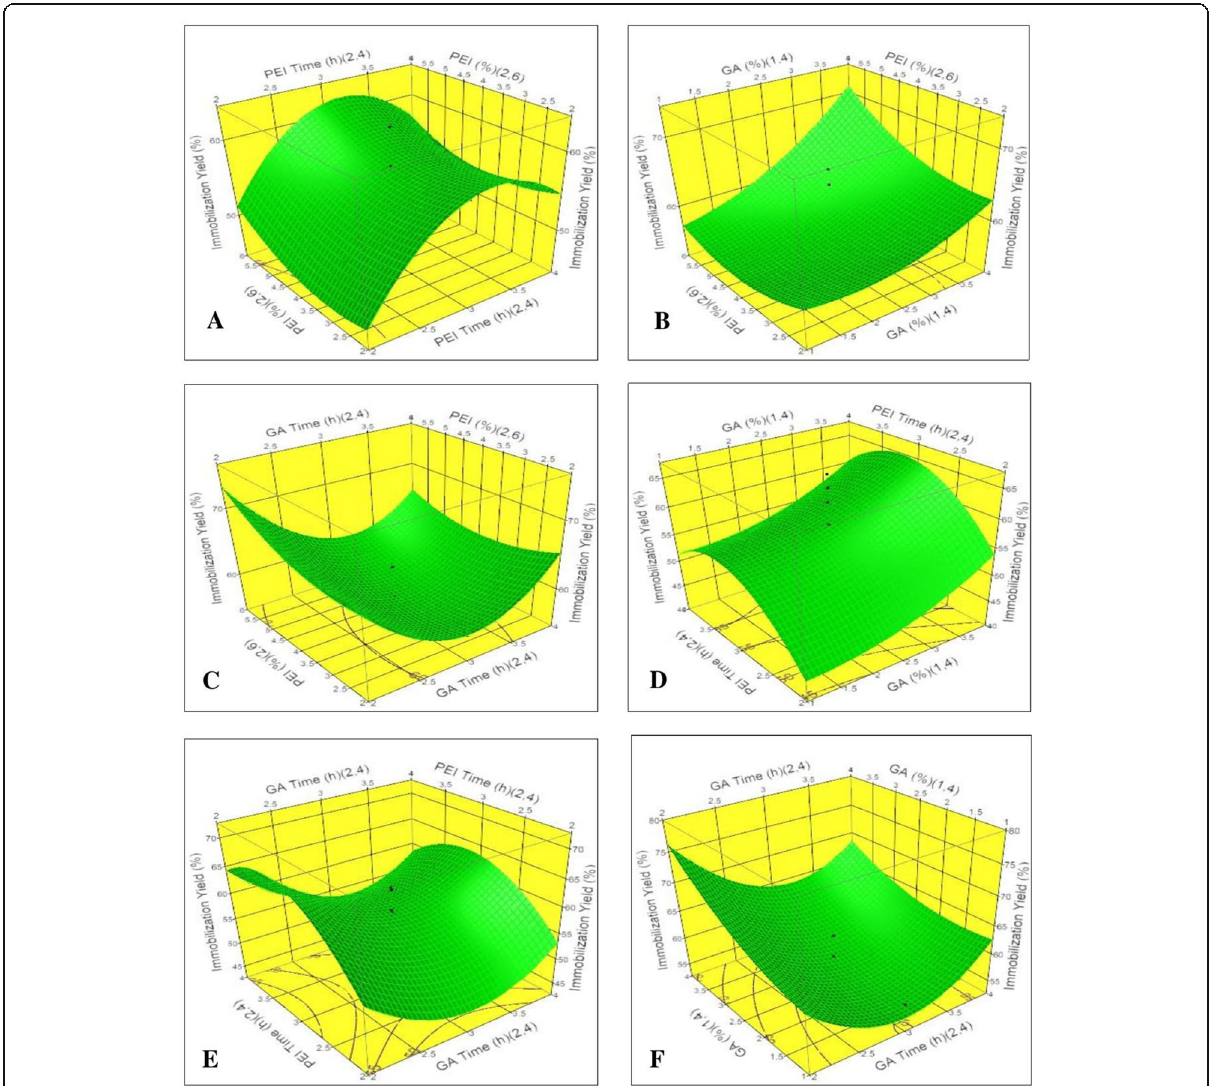
Fig. 7 The 3D surface plots representing interaction between factors affecting IY of α -amylase. a PEI percent and PEI activation time. b PEI percent and GA percent. c PEI percent and GA activation time. d PEI activation time and GA percent. e PEI activation time and GA